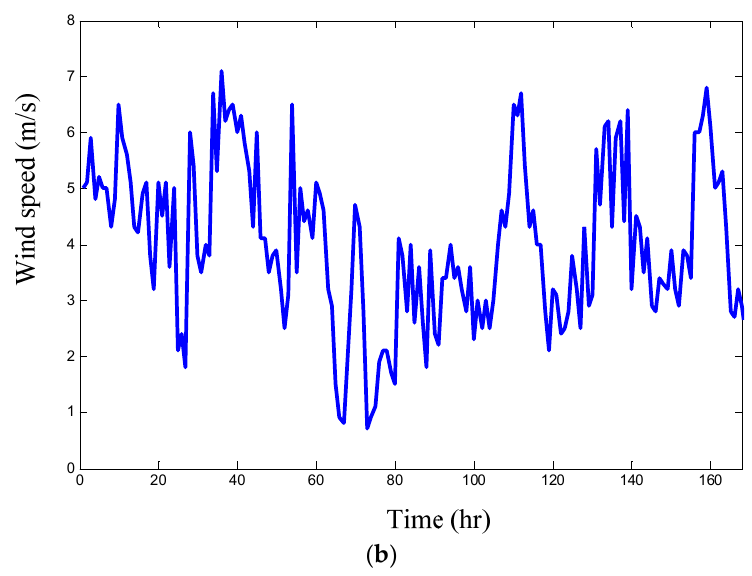
Figure 6. The curves of the typical weekly wind speed ( a ) winter; ( b ) summer.